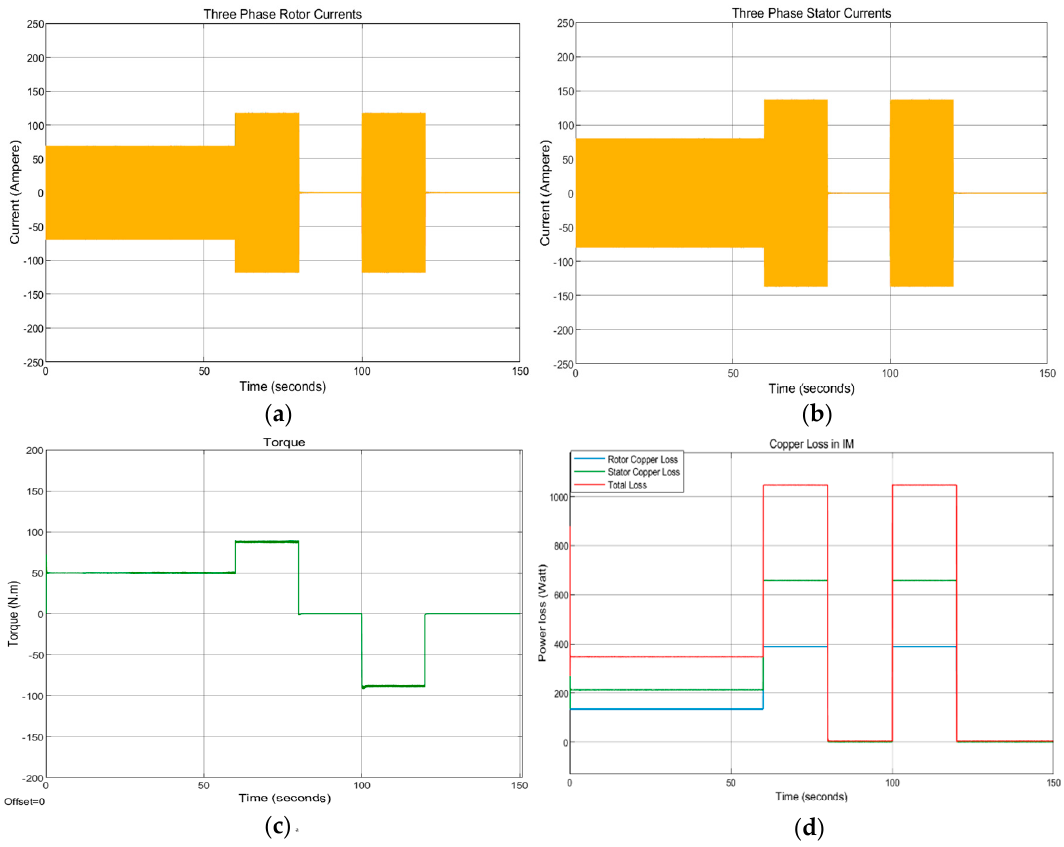
Figure 15. ( a ) Three phase rotor currents; ( b ) Three phase stator currents; ( c ) Torque commands; ( d ) Copper losses in rotor and stator of IM.